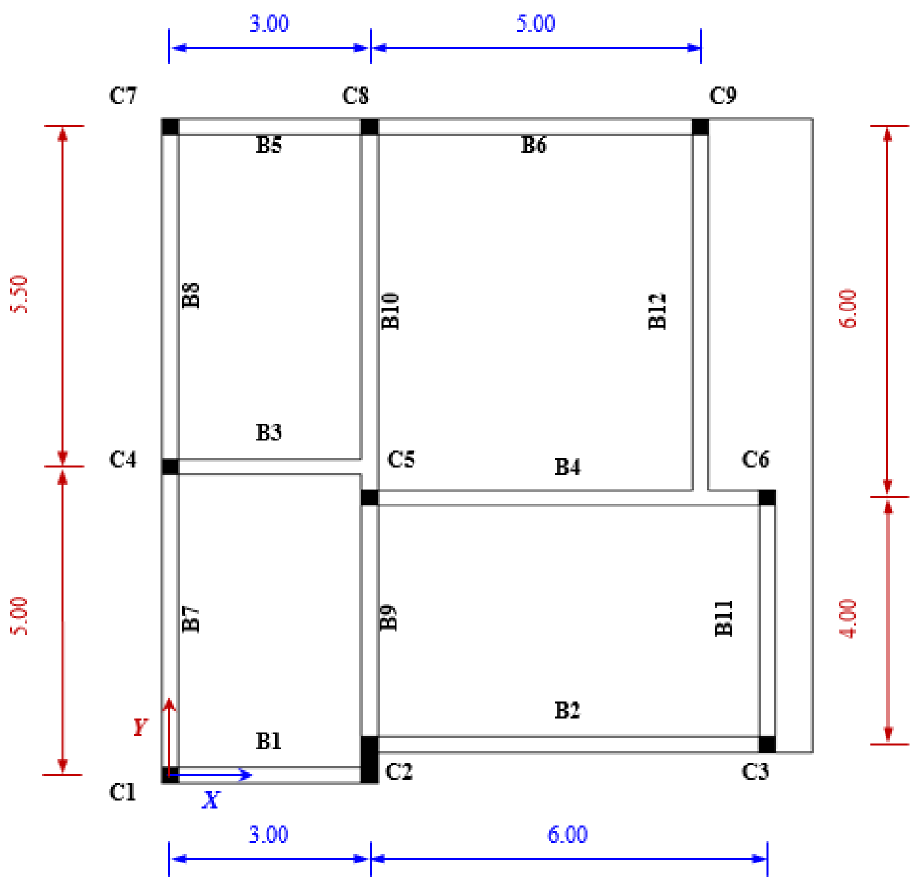
Figure 6. Typical story plan of the SPEAR test building at ELSA-JRC, Ispra, Italy (units in